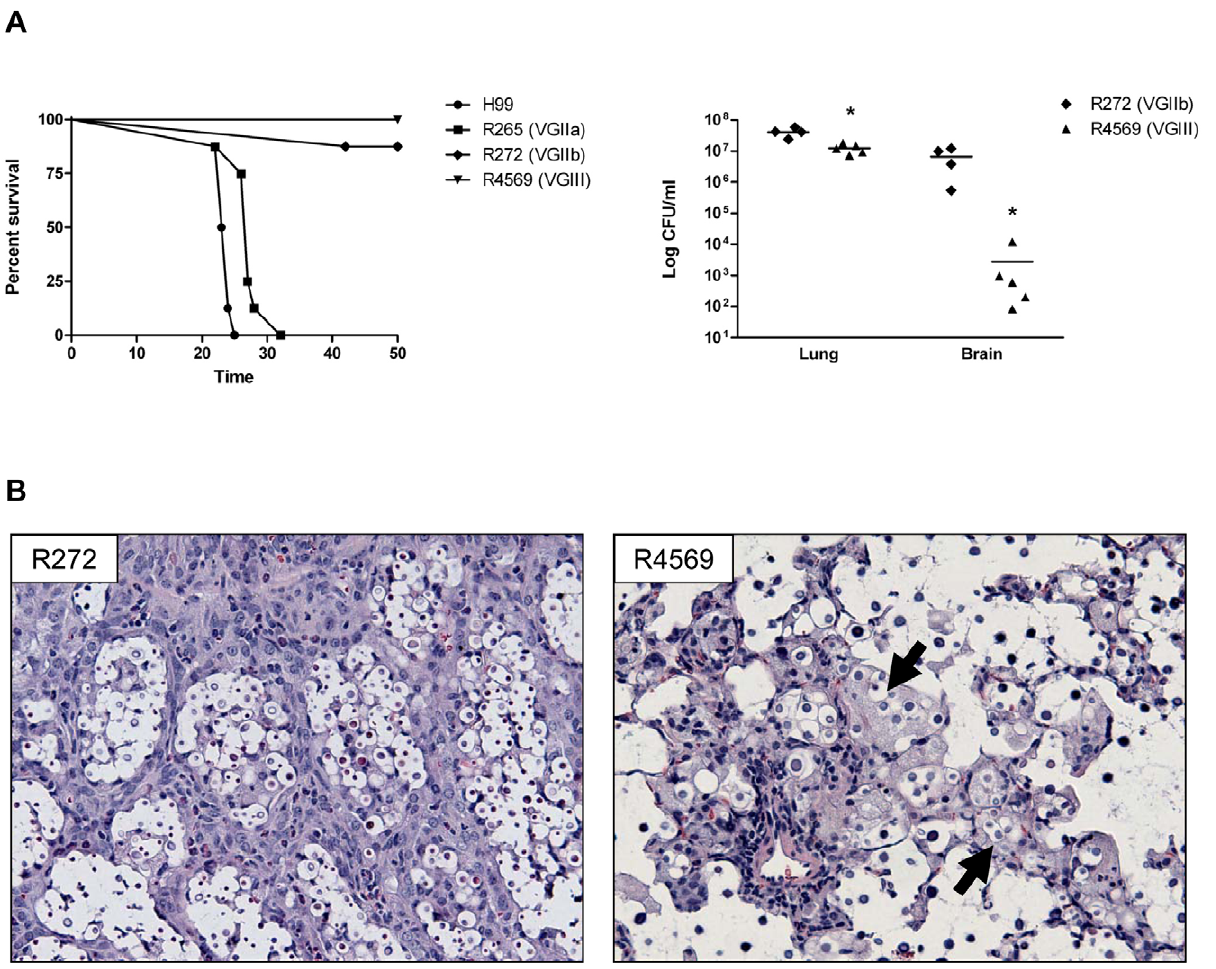
Figure 4. Strain R4569 is hypovirulent compared to VGII strains R265 and R272. a. Eight mice per group were intranasally inoculated with 1 6 10 5 CFU of each strain and monitored for disease. Mice infected with C. neoformans strain H99 or C. gattii strain R265 had mean survival times of 23.5 and 27 days, respectively. 87.5% of mice survived infection with R272, and all mice infected with R4569 survived. Survival curves between R272 and R4569 were not significantly different, but fungal burden determination at day 50 post-infection revealed significantly less yeast in the lungs and brains of mice infected with R4569 ( p , 0.05, Student’s t -test). b. Sections of lung from mice infected with R272 show greater numbers of organisms as compared to infections from R4569. There are also increased numbers of lymphocytes and macrophages around aggregates of yeast with R272 than observed with R4569. Additionally, yeasts are found within ‘‘foamy’’ macrophages with R4569 (arrows) suggesting greater control of the infection.